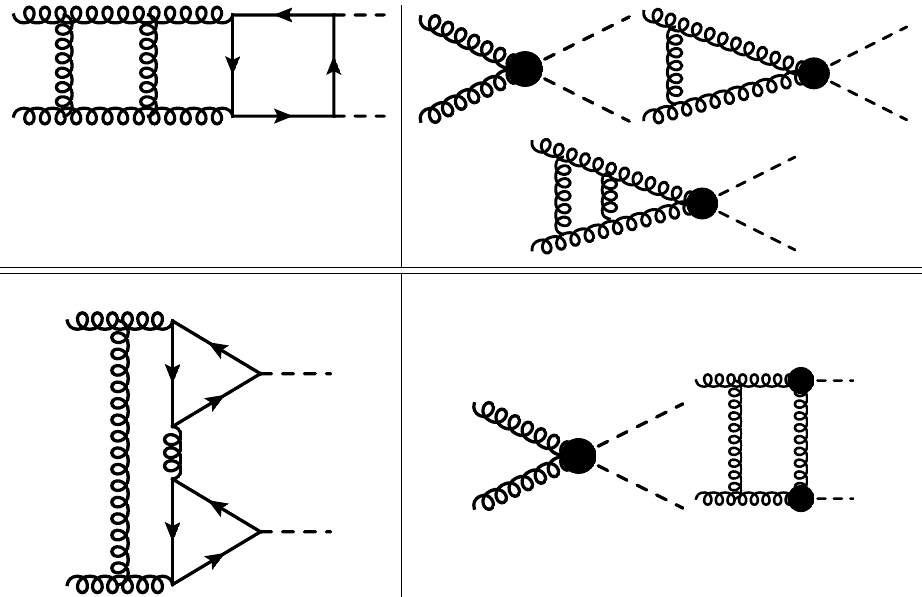
Figure 2 . Sample three-loop diagrams (left) and the corresponding co-subgraphs (right) which result from the asymptotic expansion according to eq. (3.1). The blobs represent e(cid:11)ective vertices from the hard subgraphs. They correspond to vacuum